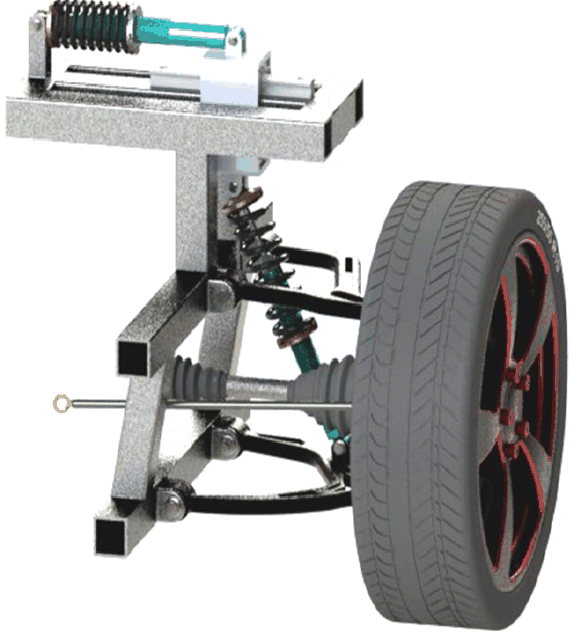
Figure 2. Variable Sti ff ness Suspension System.